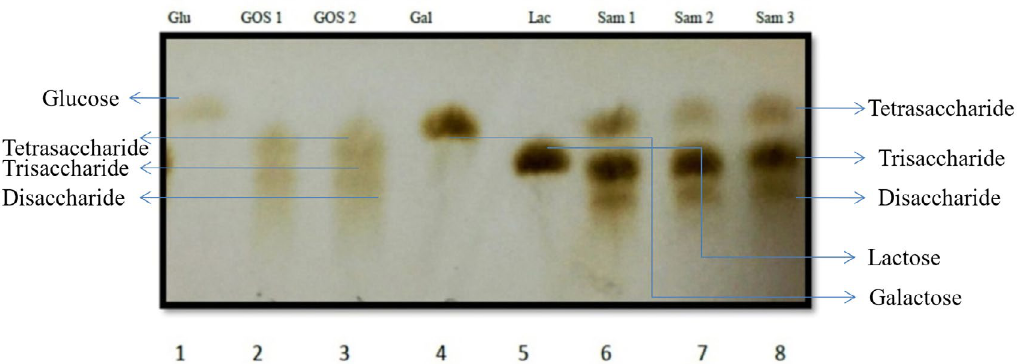
Fig. 4. Synthesis of GOS from L. fermentum with beta-gal enzymes and galactooligosaccharide mixtures are identified as follows: Line 1- Glucose; Line 2- Standard GOS (3:1); Line 3-Standard GOS (4:1); Line 4-Galactose; Line 5- Lactose; Line 6- L. fermentum (18hr), Line 7- L. fermentum (20hr); Line 8- L. fermentum